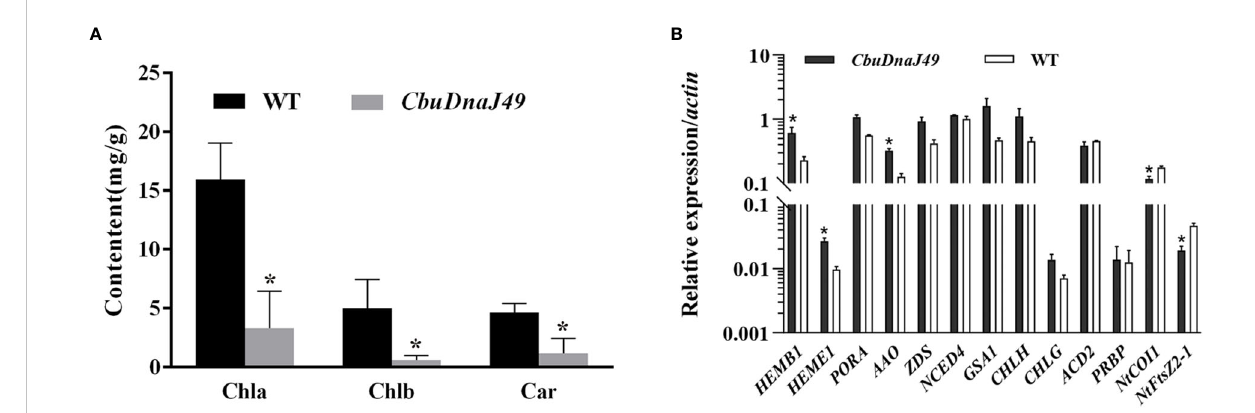
FIGURE 8 Pigment content detection and expression of the genes related to pigment metabolism and chloroplast development. (A) Identi fi cation and expression analysis of CbuDnaJ49 and pigment content in transgenic and WT plants of tobacco. Student ’ s t test, P < 0.05. (B) Expression of the genes for pigment metabolism and chloroplast binding proteins. Student ’ s t test, P < 0.05. * represents signi fi cant